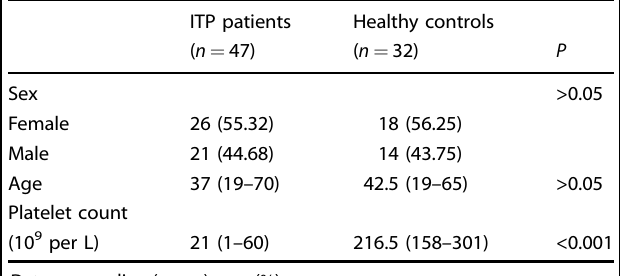
Table 2. Baseline characteristics of patients with ITP